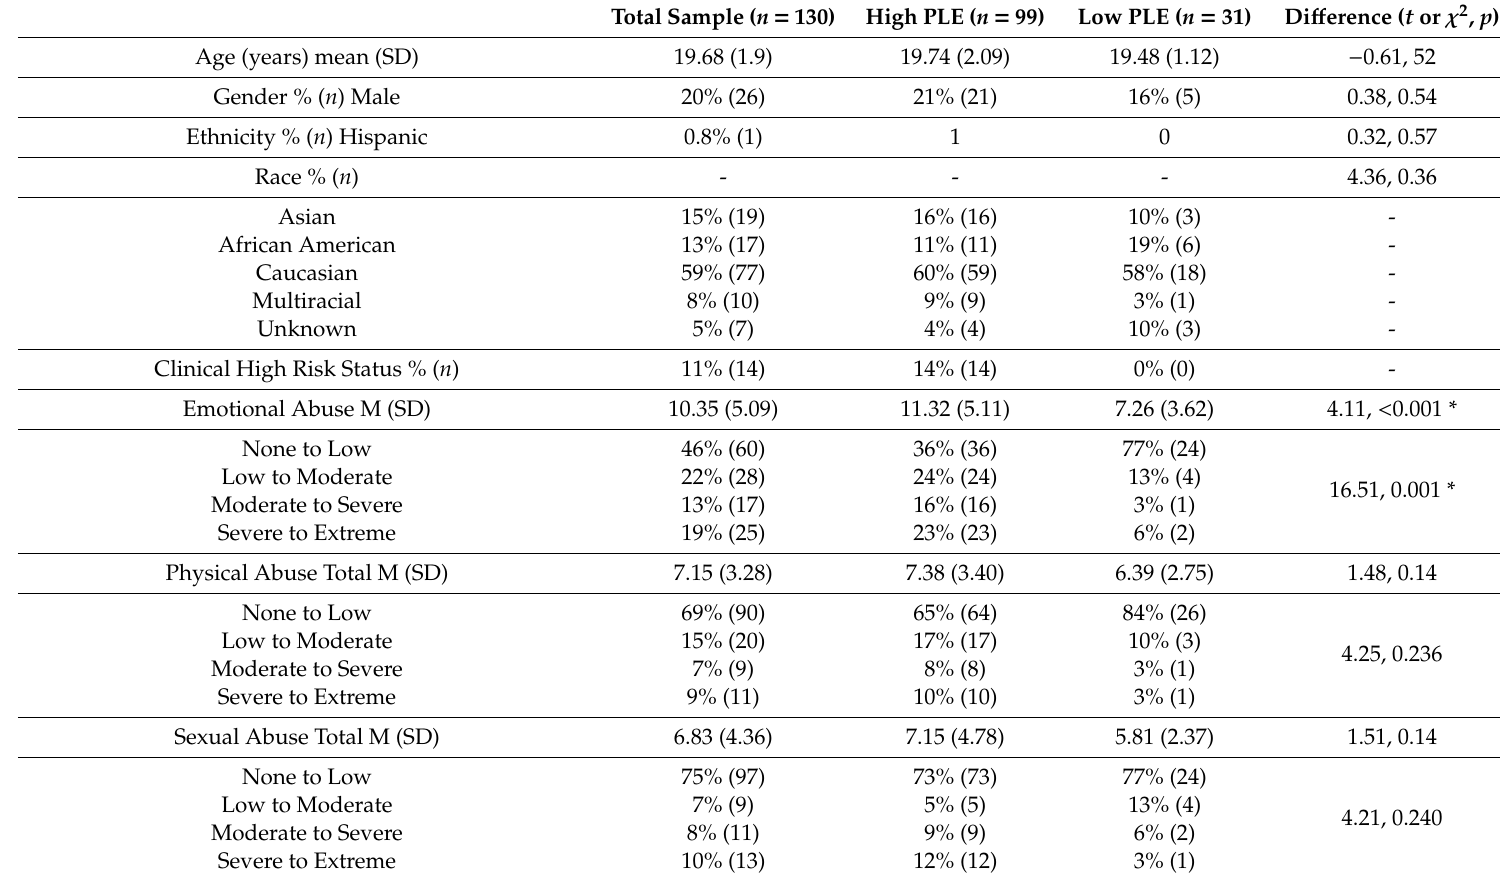
Table 1. Demographics and clinical features of